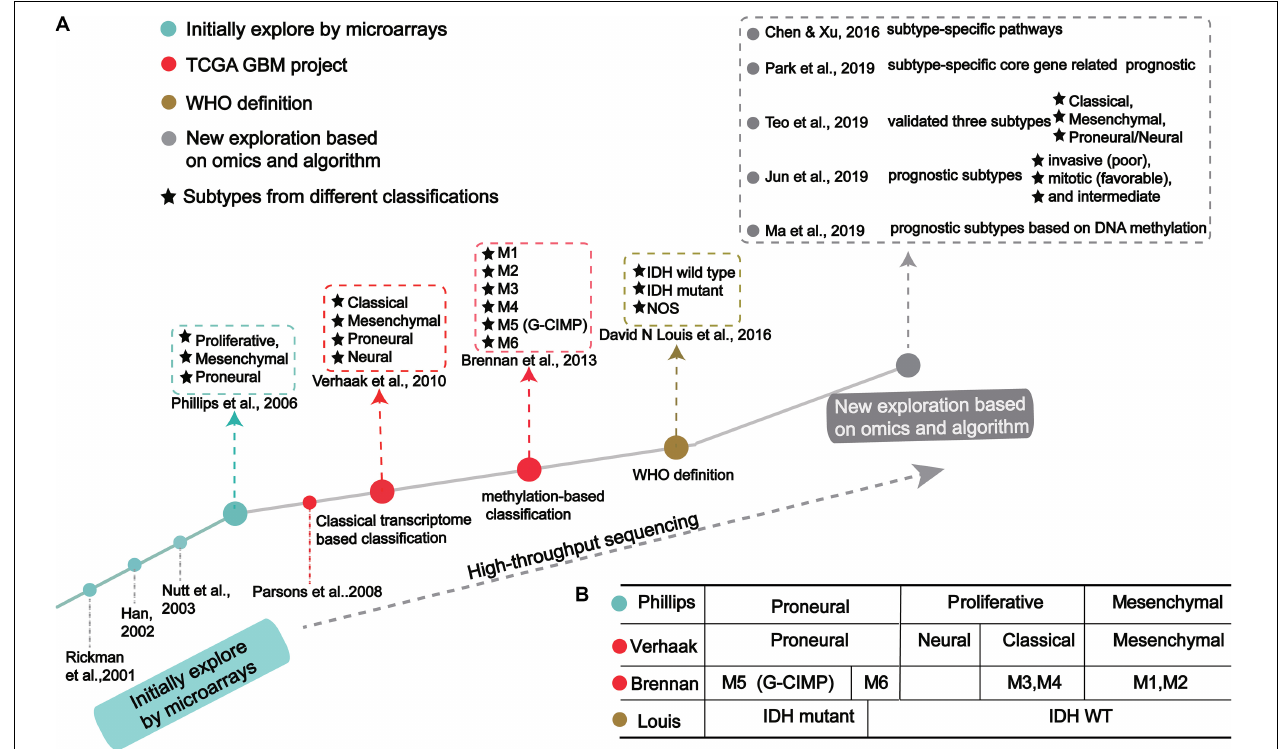
FIGURE 1 | The process of molecular-based GBM classification: (A) GBM classification timeline and classical subtypes. (B) The relative overlap between subtypes from different classification methods.